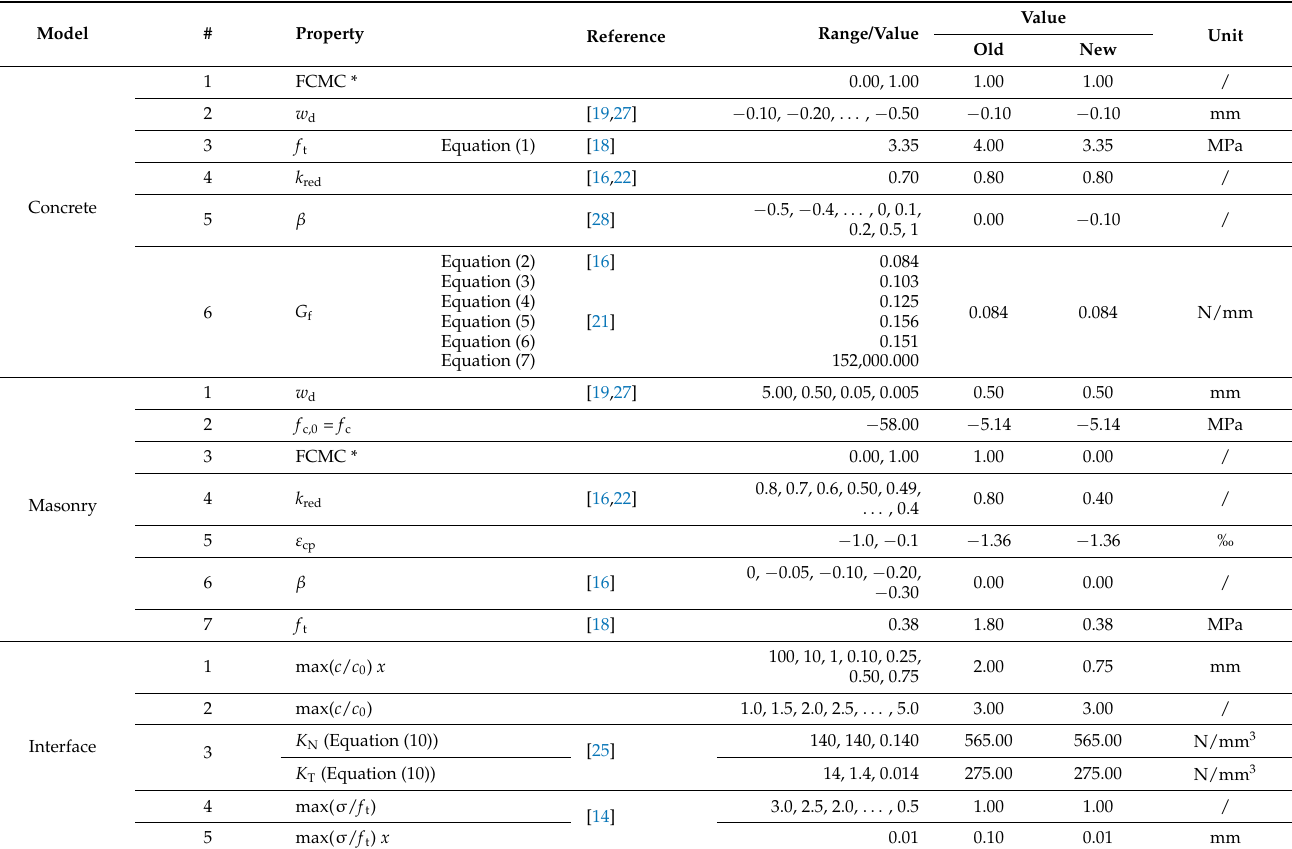
Figure 15. Multi-linear spring. The overview of parameters changed can be seen in Table 5. In the column: model refers to the material model; property to the parameter that was varied; reference provides citations on which the change was based on; range/value to the range or the value of the parameter (property) that was varied; value old/new the inherent or adopted values from the range/value column. The table does not specify what part of the test simulation (IP or OoP) prompted the adaption of a certain parameter, which is described in Section 3. Results and discussions. Table 5. Varied